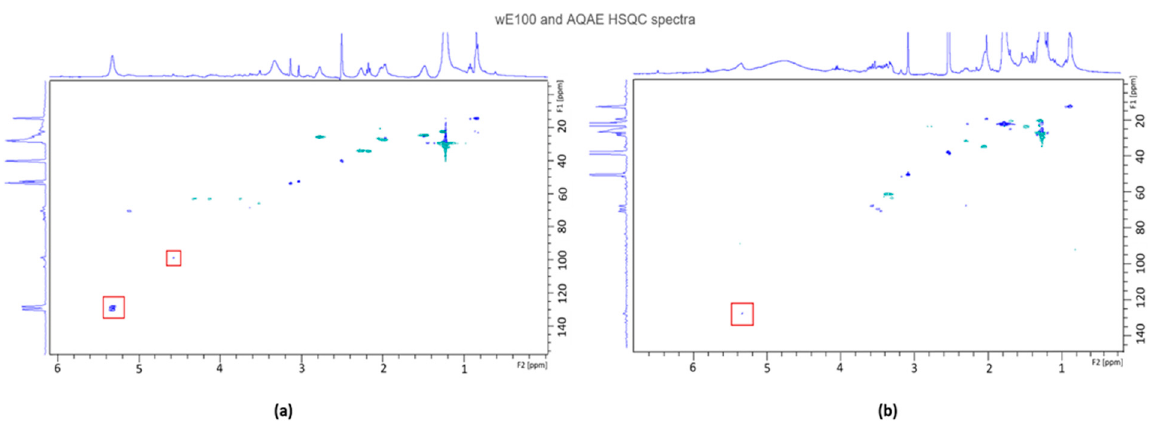
Figure 4. HSQC bidimensional NMR (proton and carbon-13) spectra of both extracts of Undaria pinnatifida selected for product development. ( a ) Spectrum of wE100 extract. ( b ) Spectrum of AQAE extract. Squares highlight possible phlorotannin peaks.